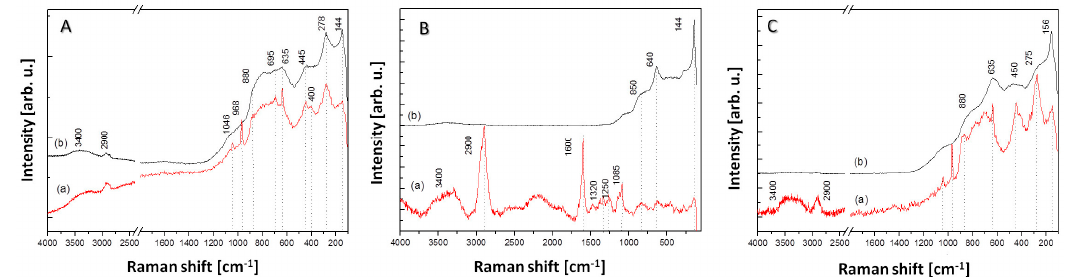
Figure 9. Raman spectra of ( A ) TM-alkali treatments (AT); ( B ) TNZ-AT; ( C ) TAN-AT samples. (Red line: Anodized titanium alloy samples; Black line: Immersed in NaOH solution.)